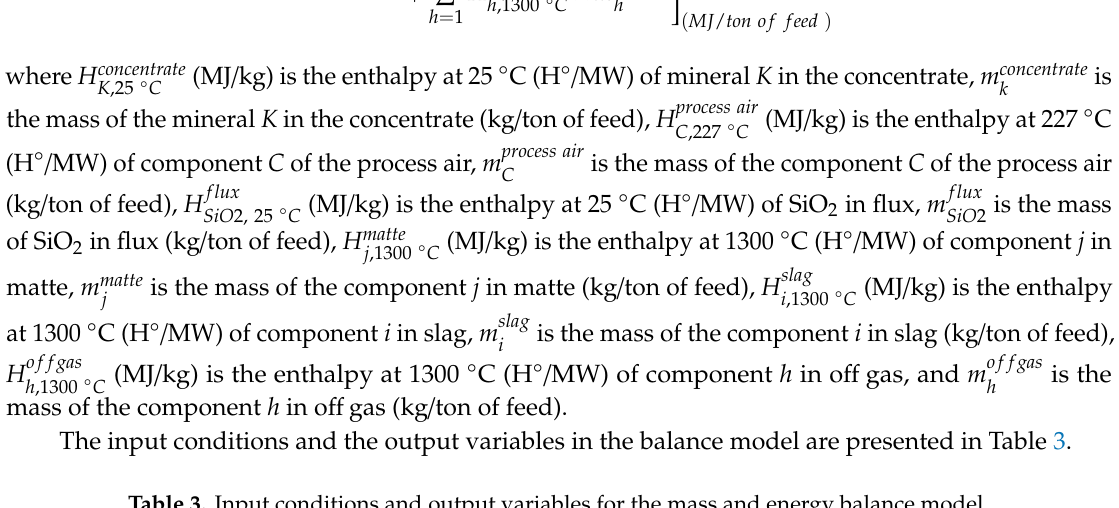
Table 3. Input conditions and output variables for the mass and energy balance